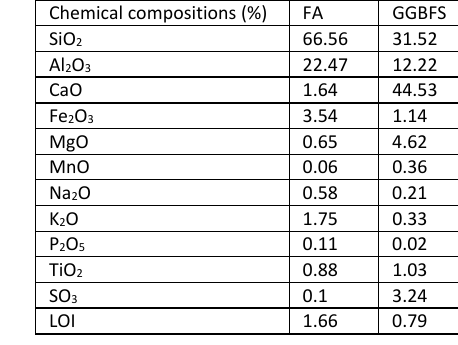
Table 1. Chemical Composition of FA and GGBFS.